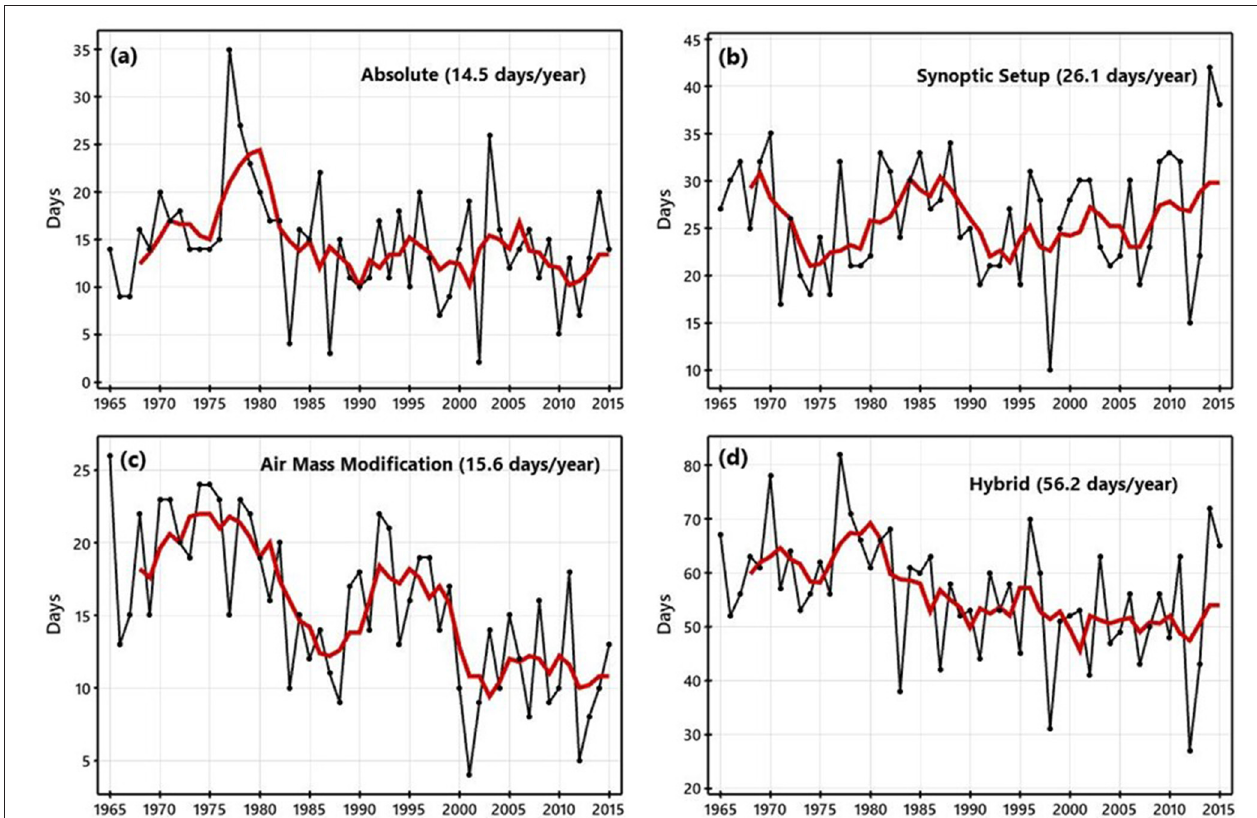
FIGURE 6 | Time series of seasonal lake-effect frequency (days) for absolute lake-effect days (a) , synoptic setup-defined days (b) , air mass modification-defined days (c) , and for the three classes combined (hybrid) (d) for the period 1964–65 through 2014–15. The red line is a 5-year running mean. The period of record annual mean for each is